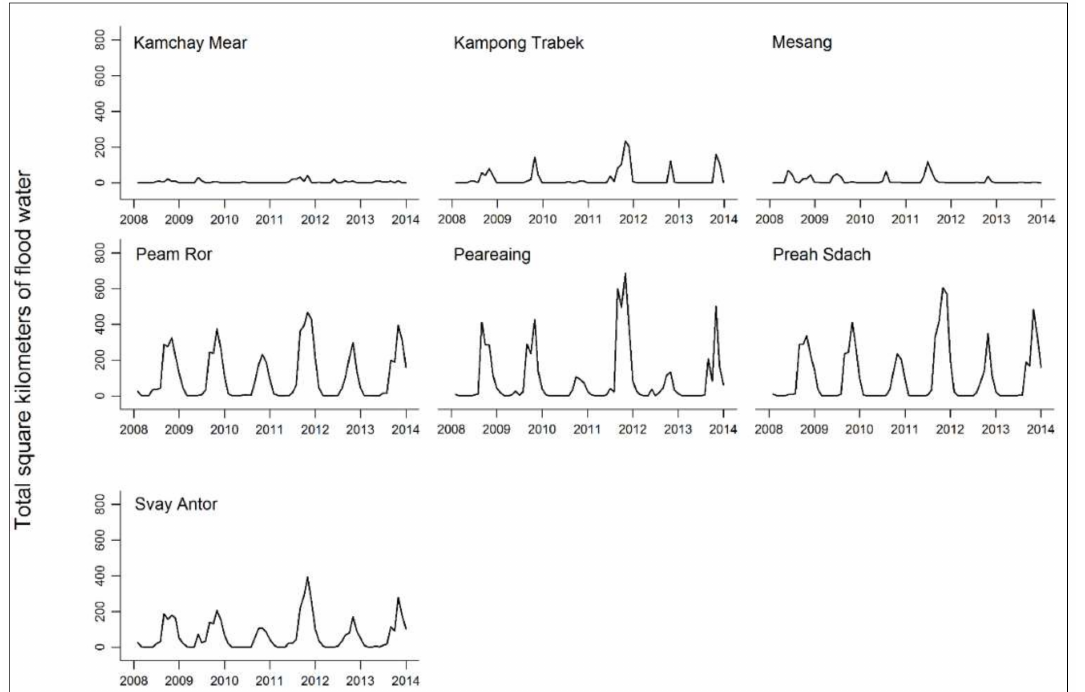
Figure 4. Total number of square kilometers flooded in the districts of Prey Veng province between January 2008 and December